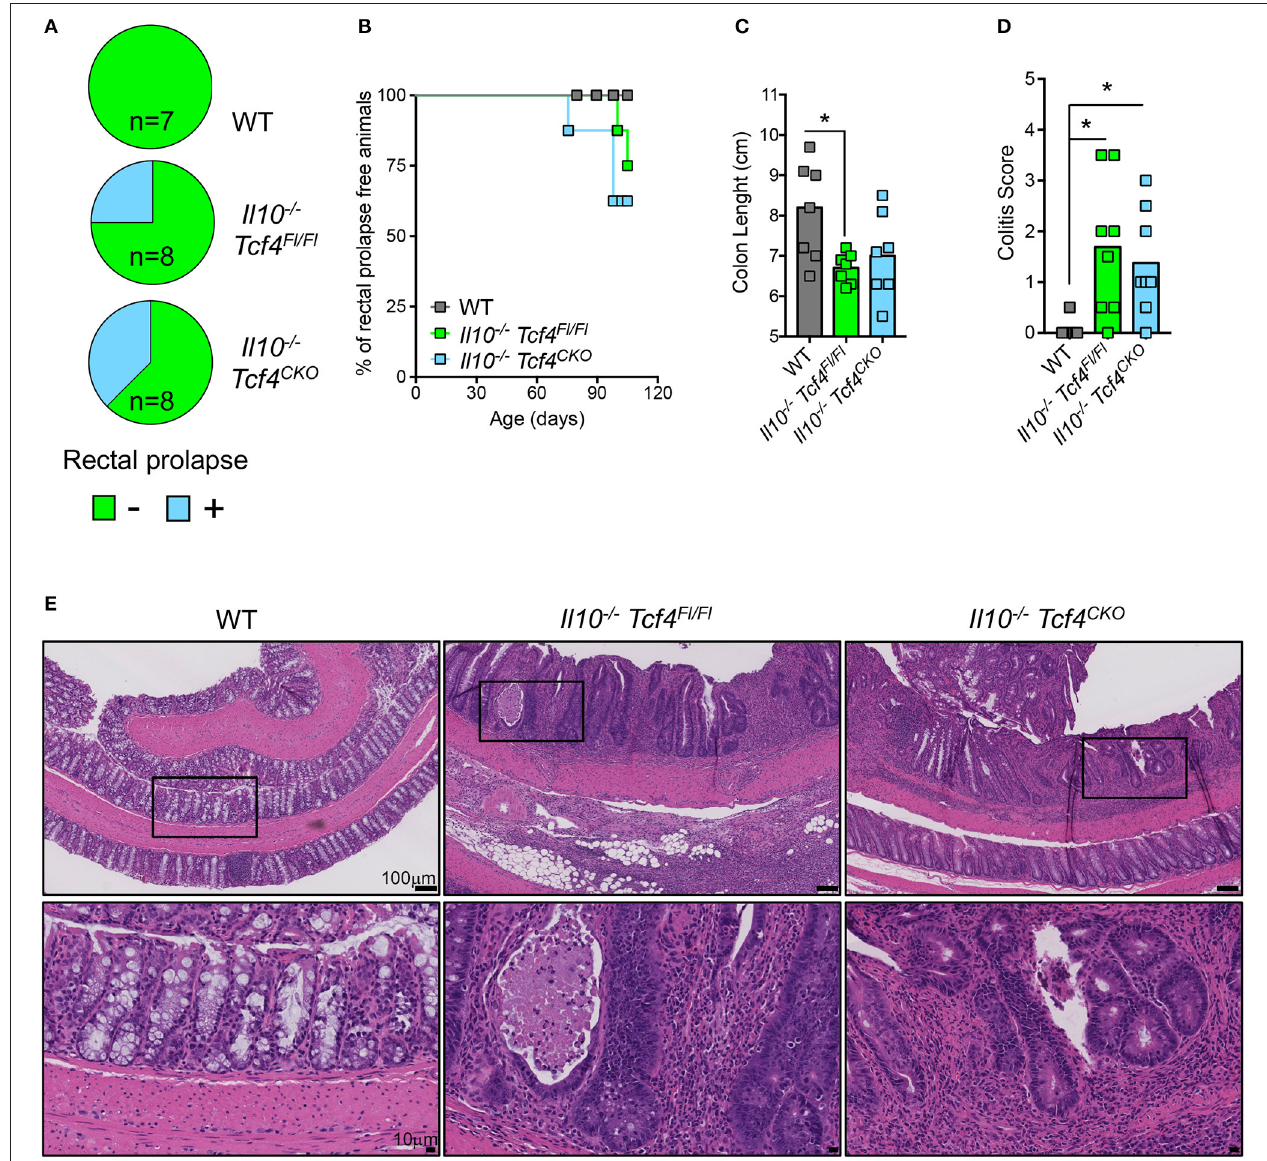
FIGURE 7 | DC-specific deletion of Tcf4 does not prevent colitis development in Il10 -deficient mice. Il10 − / − Itgax -Cre − Tcf4 flox / flox ( Il10 − / − Tcf4 Fl / Fl ) or Il10 − / − Itgax -Cre + Tcf4 flox / flox ( Il10 − / − Tcf4 CKO ) littermates with DC-specific Tcf4 CKO were analyzed along WT controls at 15 weeks of age. (A) Rectal prolapse in animals of the indicated genotype. Data are represented as pie charts indicating the frequency of animals with (blue) and without (green) rectal prolapse. (B) Kaplan-Meier plot indicating the percentage of rectal prolapse free mice over time in the indicated genotype ( n = 8/genotype). (C) Colon lengths from individual mice of the indicated genotype. Data were pooled from 3 independent experiments and horizontal bars represent the median. (D) Histopathological scores of the colon pathology were determined from individual indicated animals. Bars represent the median and data were pooled from 3 independent experiments. (E) Colon paraffin sections of the indicated mice were stained by H&E and analyzed by microscopy (scale bars, 100 µ m). Upper panels represent a 10X magnification (scale bar, 100 µ m) and lower panels show a 40X magnification (scale bar, 10 µ m) of the indicated area (square). Images are representative of 6 animals in each group from 3 independent experiments. Statistical significance estimated by Kruskal-Wallis test followed by a post-hoc Dunn’s multiple comparison test is indicated as follows * P ≤